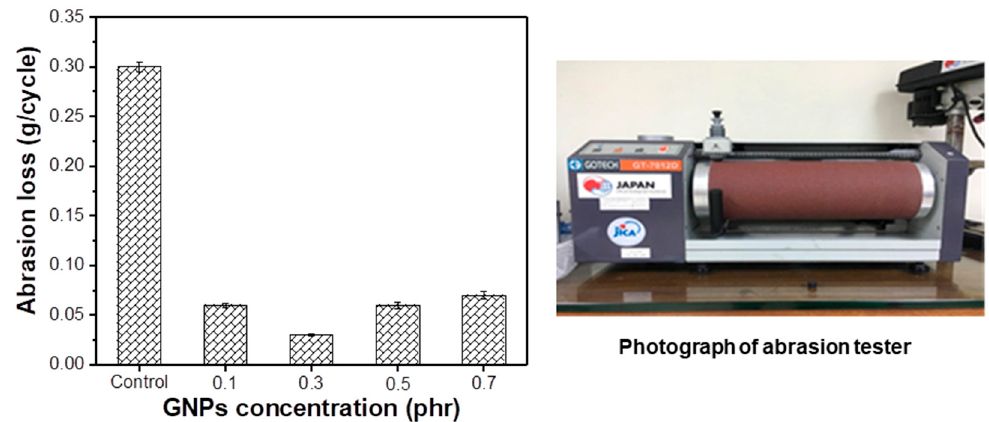
Figure 6. Abrasion loss of the control sample and the DOP-modified GNPs/NR rubber composites with various graphene contents.